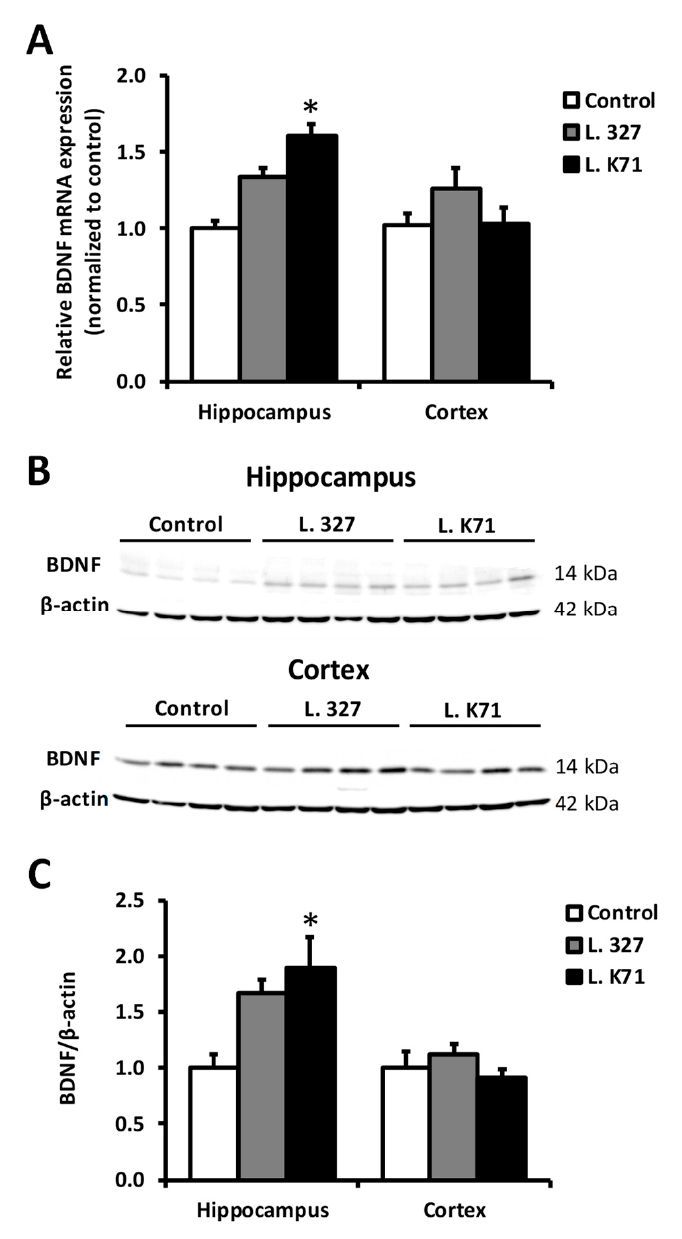
Figure 5. Effects of 43-week Lactobacillus strain administration on the expression levels of brain-derived neurotrophic factor (BDNF) in the hippocampus and cortex of SAMP8. ( A ) Bdnf mRNA levels measured by quantitative PCR ( n = 8 mice per group); ( B ) Western blotting analysis ( n = 4 mice per group) of the protein levels of BDNF; ( C ) Quantification of band intensities in ( B ). Data are expressed as mean ± SEM, * p < 0.05 vs. the control group.